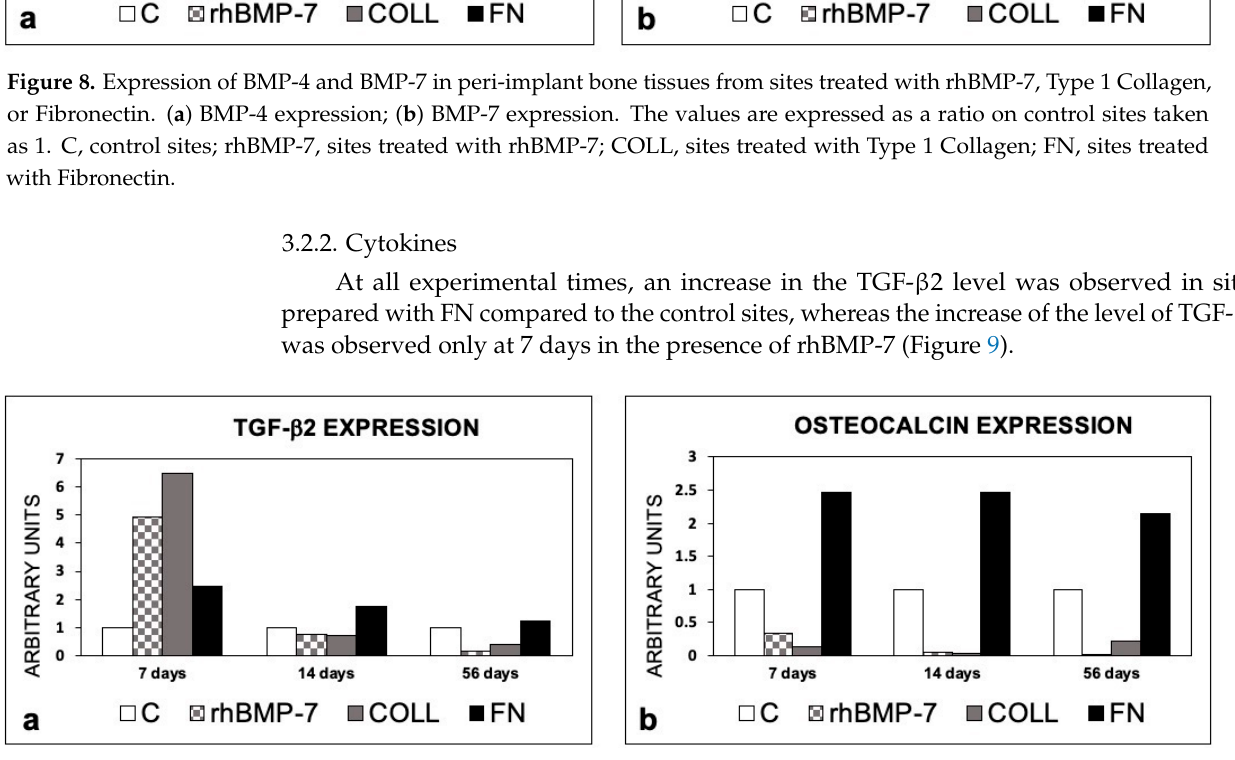
Collagen, or Fibronectin. ( a ) TGF- β 2 expression; ( b ) Osteocalcin expression. The values are expressed as a ratio on control sites taken as 1. C, control sites; rhBMP-7, sites treated with rhBMP-7; COLL, sites treated with Type 1 Collagen; FN, sites treated with Fibronectin.